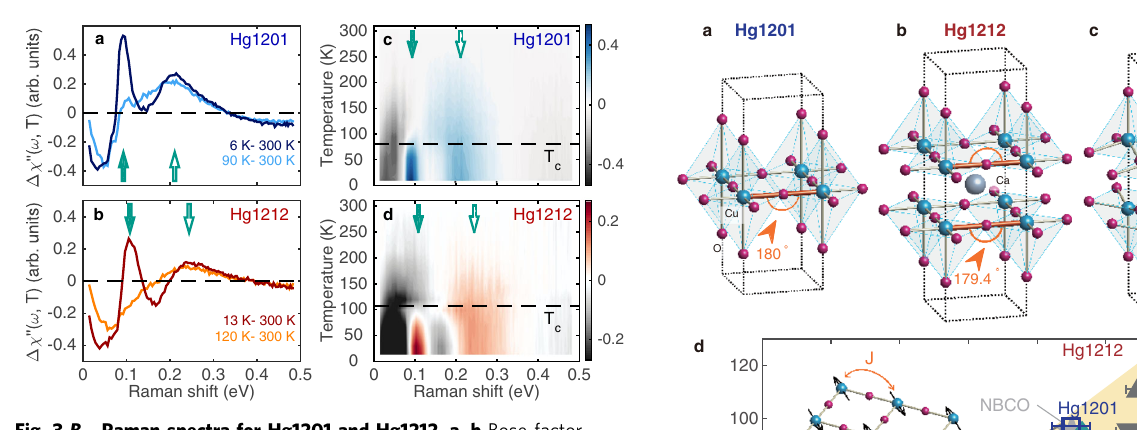
Fig. 3 B 1g Raman spectra for Hg1201 and Hg1212. a , b Bose-factor corrected electronic Raman spectra relative to 300 K for Hg1201 and Hg1212, respectively. The B 1g scattering geometry involves incident and scattered photons linearly polarized along the diagonals of the CuO 2 plaquettes, and perpendicular to each other. c , d False-color representation of Raman spectra at various T relative to 300 K. Solid arrows indicate the energy of the pair-breaking peak, at 93 (108) meV for Hg1201 (Hg1212), and empty arrows the two-paramagnon peak, at 211 (244) meV for Hg1201 (Hg1212), estimated from spectra obtained at the lowest temperature. Additional data are presented in Supplementary Fig. 9.